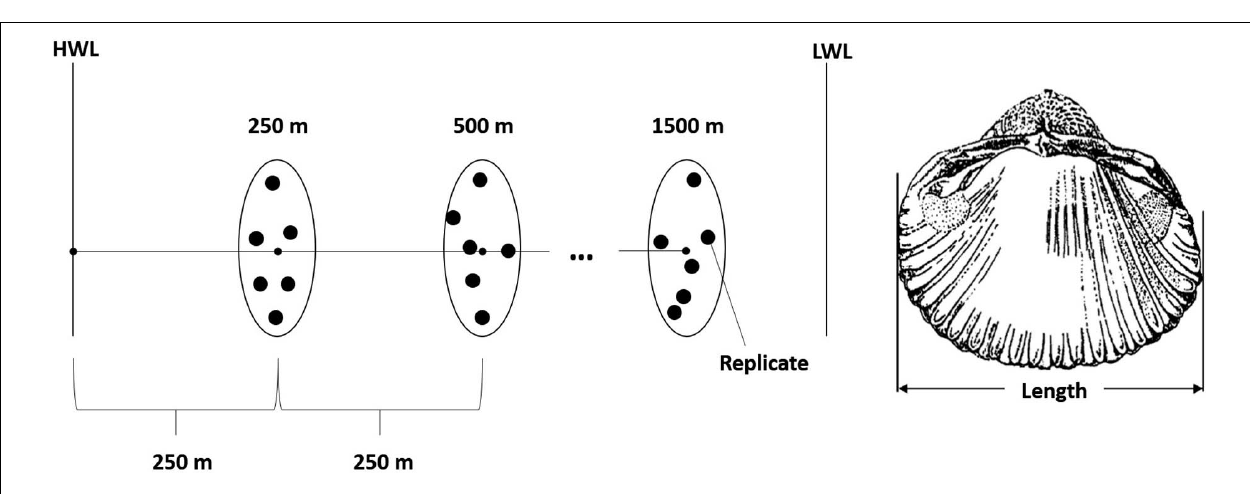
around Mellum are given for summer and winter.